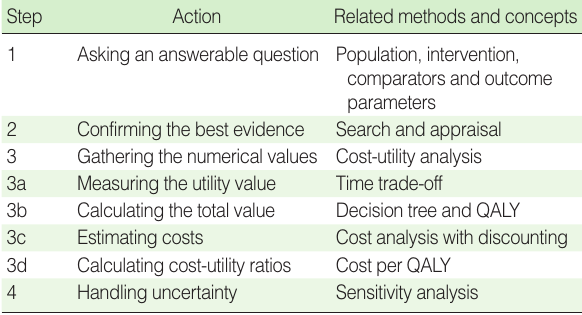
Table 1. Four steps of applying value-based medicine